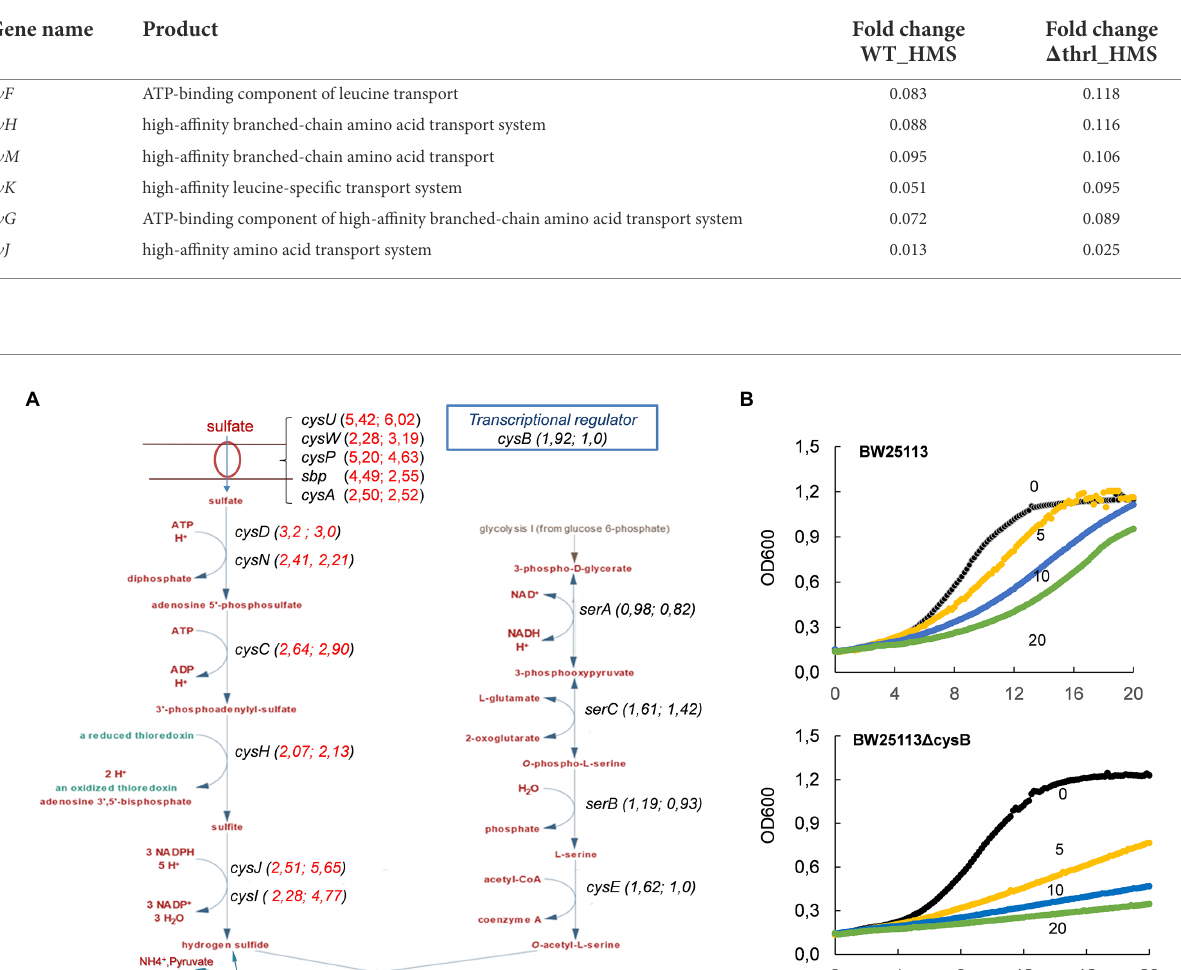
TABLE 5 Genes encoding component of the branched amino acid transport system downregulated in WT and Δ thrL strains in response to L-homoserine.